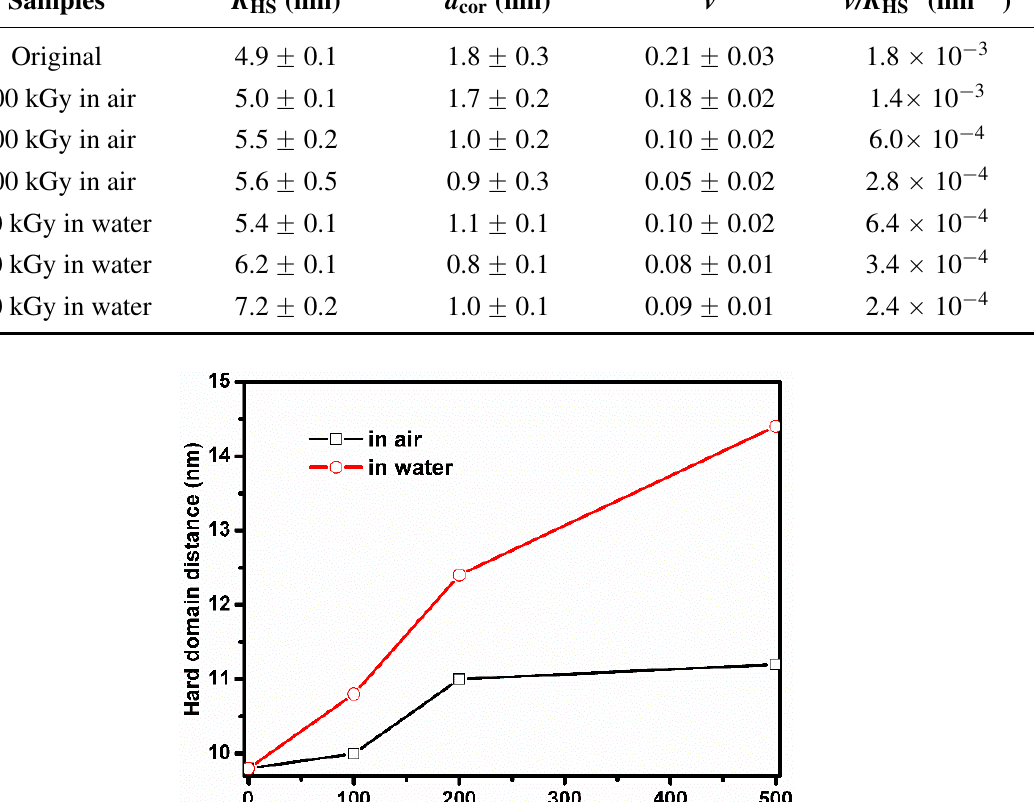
Table 1. Structural parameters obtained from SANS data on irradiated Estane samples by curve-fitting using the DAB-PY model.